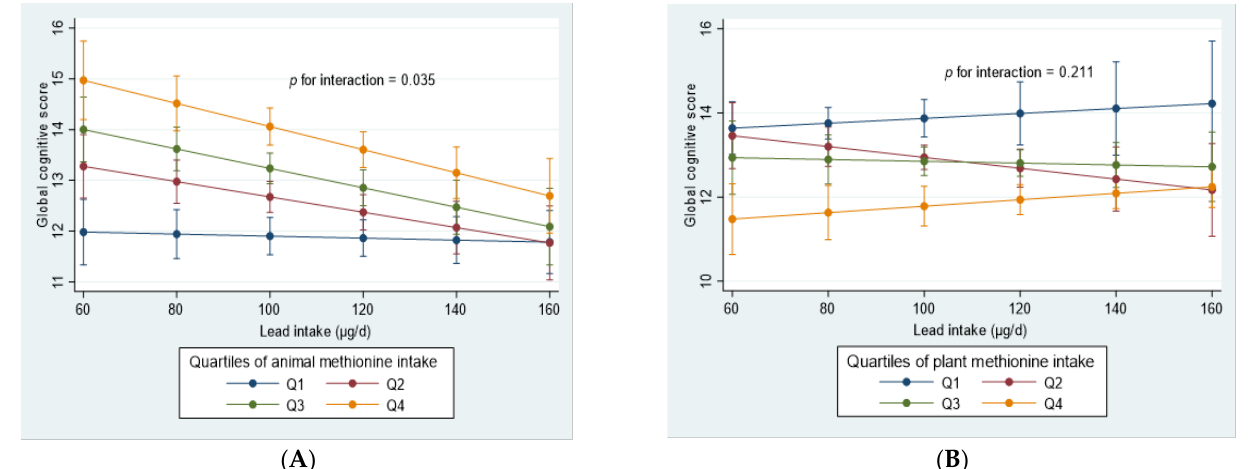
Figure 1. Interaction of animal ( A ) and plant methionine ( B ) intake with lead intake in relation to cognition among adults participating in the China Health and Nutrition Survey (CHNS) during 1997–2006. Values are means (95% CIs) derived by using the margins command in Stata after running a mixed linear model adjusted for age, gender, energy intake, education, income, urbanization, smoking, alcohol drinking, physical activity, intake of fruit and vegetables, BMI, hypertension, self- reported diabetes, and stroke. All participants who attended at least two waves of the survey were included in the analyses. Q = quartile.